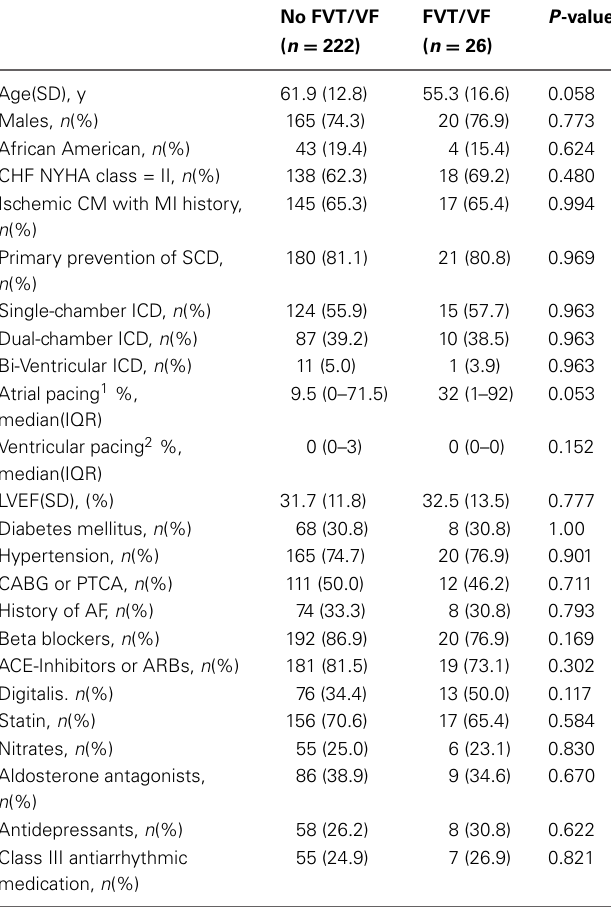
Table 3 | Comparison of baseline clinical and demographic characteristics in patients with and without FVT/VF during follow-up.